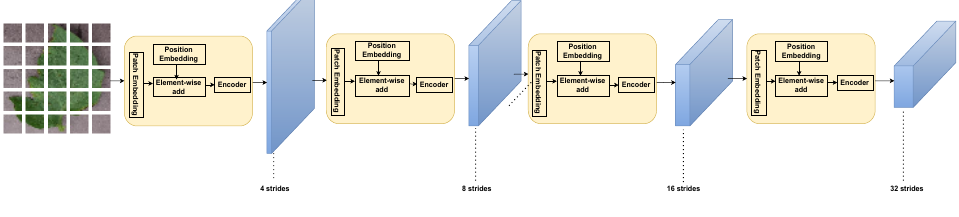
Figure 7. PVT architecture [34].